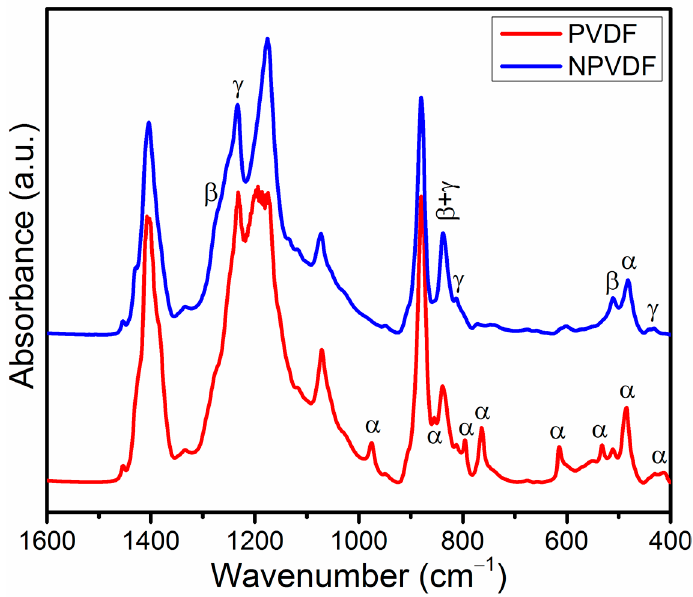
Figure 4. FTIR absorption spectra of PVDF and NPVDF films within the wide wavenumber region of 1600-400 cm − 1 .